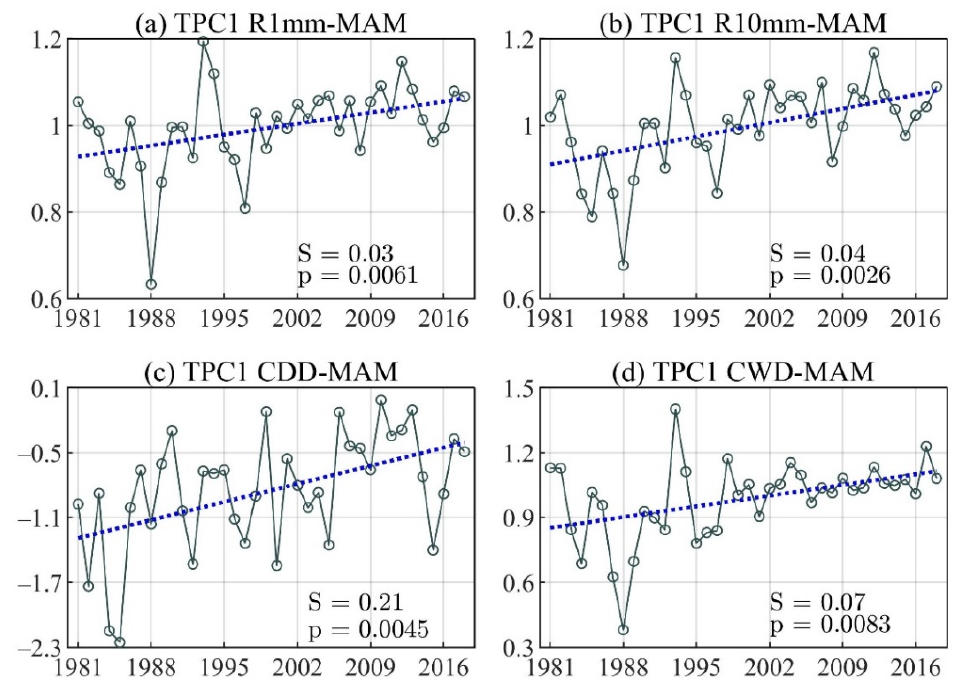
Figure A3. The linear trend of the principal component time series for the first TEOF mode of ( a ) Number of wet days (R1mm), ( b ) Number of days with precipitations above R10mm (R10mm), ( c ) Consecutive dry days (CDD), and ( d ) Consecutive wet days (CWD) during the December–February (DJF) season.